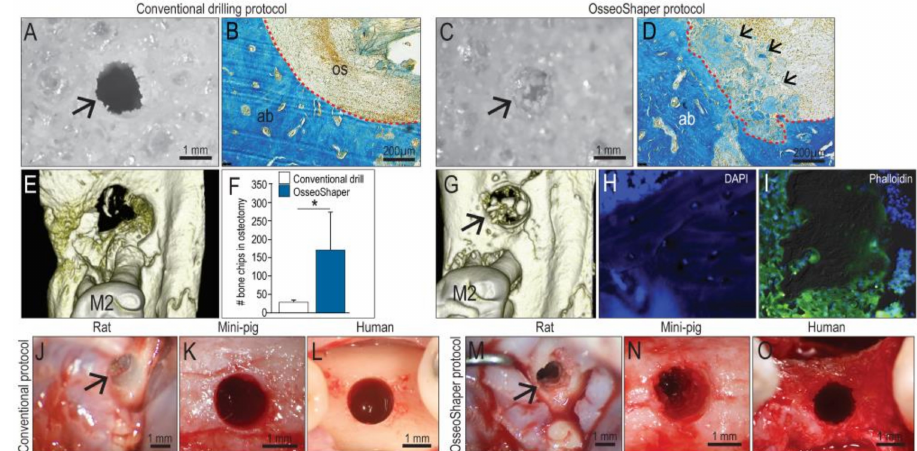
Figure 2. OsseoShaper-produced osteotomies retain more viable bone chips and osseous coagulum. Gross view of a hole produced in 0.32 g/cc Sawbone prepared with ( A ) a conventional drilling protocol versus ( C ) OsseoShaper. Representative transverse sections stained with aniline blue in the osteotomy sites using ( B ) a conventional drilling protocol and ( D ) OsseoShaper protocol. Micro-CT imaging of an osteotomy prepared with ( E ) a conventional drilling protocol versus ( G ) an OsseoShaper. ( F ) Quantification of bone chips in the osteotomy by µ CT imaging ( N = 5). Representative tissue sections of bone chips produced by the OsseoShaper using ( H ) 4 (cid:48) ,6-diamidino-2-phenylindole (DAPI) and ( I ) phalloidin staining. Intra-operative view of an osteotomy prepared with conventional drills versus the OsseoShaper in rats ( J , M ), in mini-pigs ( K , N ), and in patients ( L , O ). Arrows indicate the osteotomy. Small arrows in ( D ) indicate the osteoid matrix. Dotted lines show the edge of the osteotomy. Asterisk indicates p < 0.05. Scale bars = 1 mm ( A , C , J – O ) and 200 µ m ( B , E ). Abbreviations: as indicated